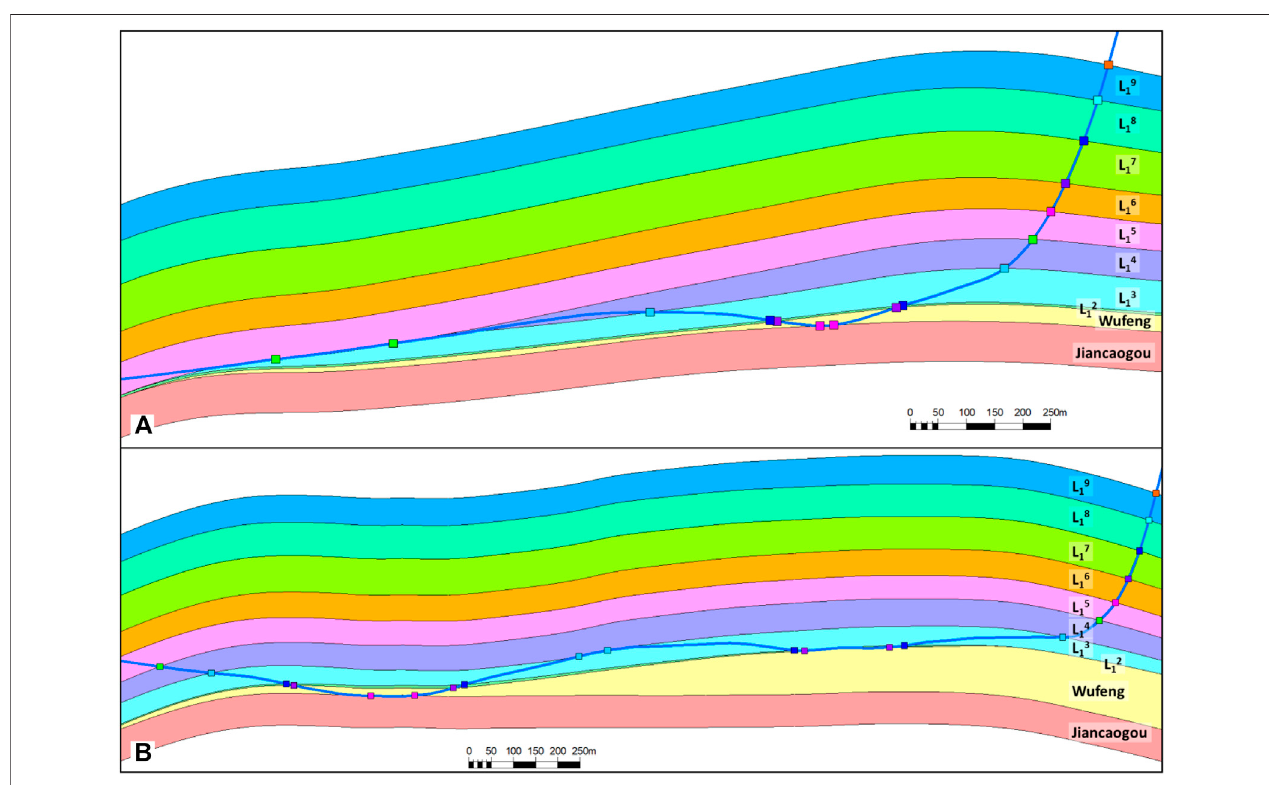
FIGURE 2 | The abnormal thickness in the lower part of the 3D structural model of the Wufeng – Longmaxi Shale reservoir in the Jiaoshiba area. (A) Cross section along the well JY-a; (B) cross section along the well JY-b.